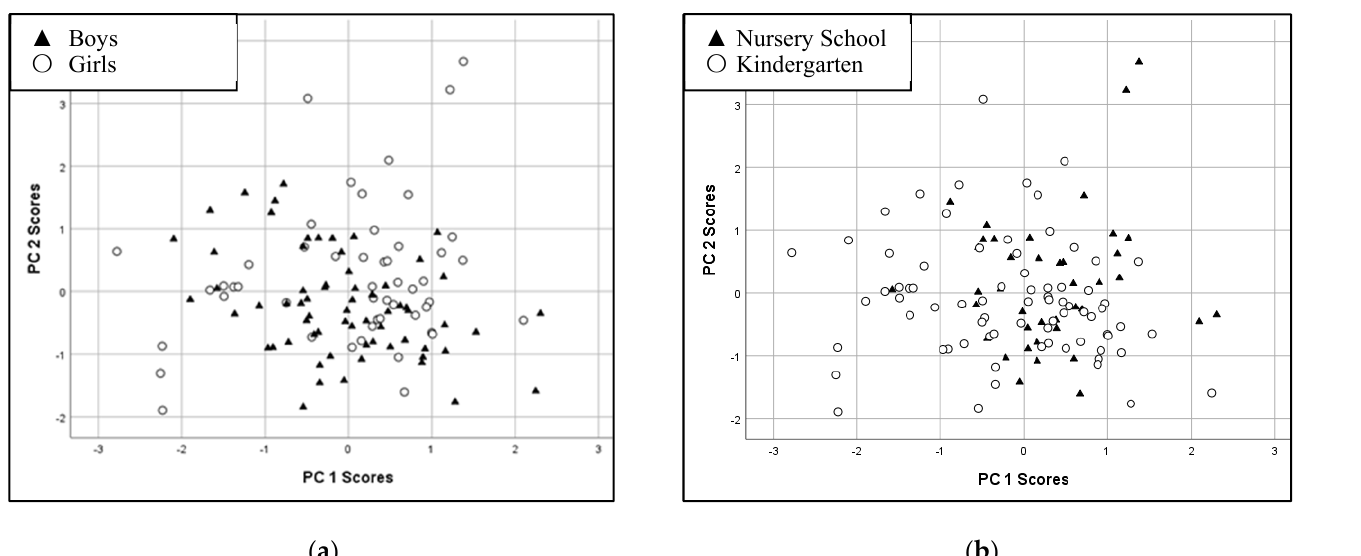
Figure 1. Score plots from the principal component analysis of 117 children’s sample *: ( a ) Boys and Girls; ( b ) Nursery school and Kindergarten. * One child with outliers for Na and Fe concentrations was excluded from the principal component analysis.